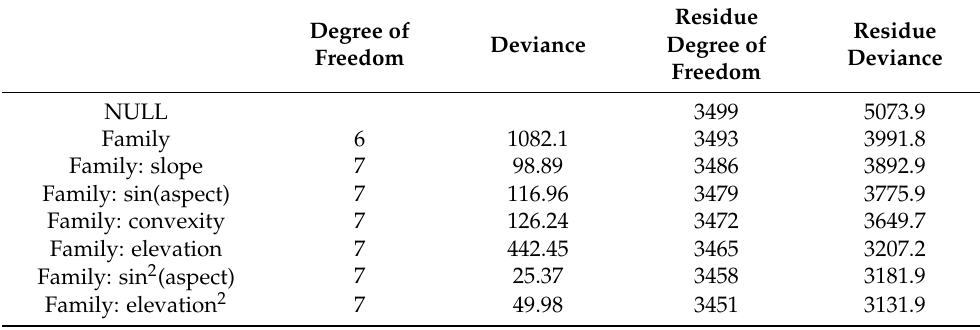
Table 2. The contribution of each variable to the reduction in deviance in the final model for liana abundance as a function of Family and its interactions with the linear and quadratic terms of four topographic variables, which were slope, sin(aspect), convexity, and elevation using a generalized linear model assuming a Poisson distribution for the response variable. “Family” was a factor, with levels of Annonaceae, Fabaceae, Gnetaceae, Primulaceae, Rubiaceae, Vitaceae, and Others. The level of Others included all families of lianas with fewer than 30 individuals in the